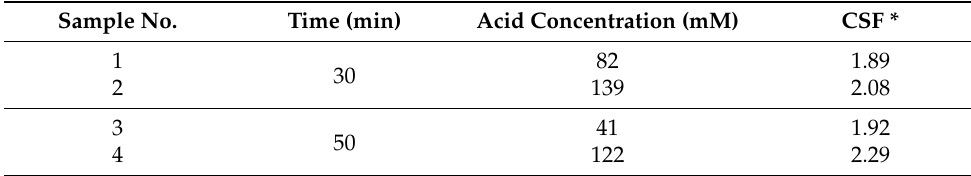
Table 1. Pretreatment of yellow poplar using oxalic acid [20]. Sample No. Time (min) Acid Concentration (mM) CSF *